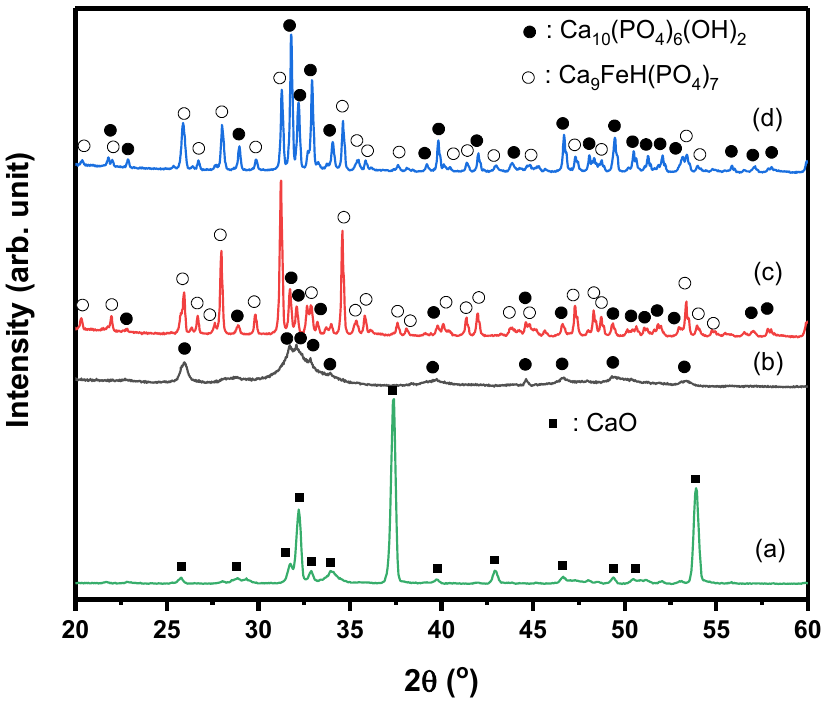
Figure 2. XRD patterns of CaO phase ( a ) and HAp synthesized by ( b ) microwave, ( c ) coprecipitation, and ( d ) sol–gel.